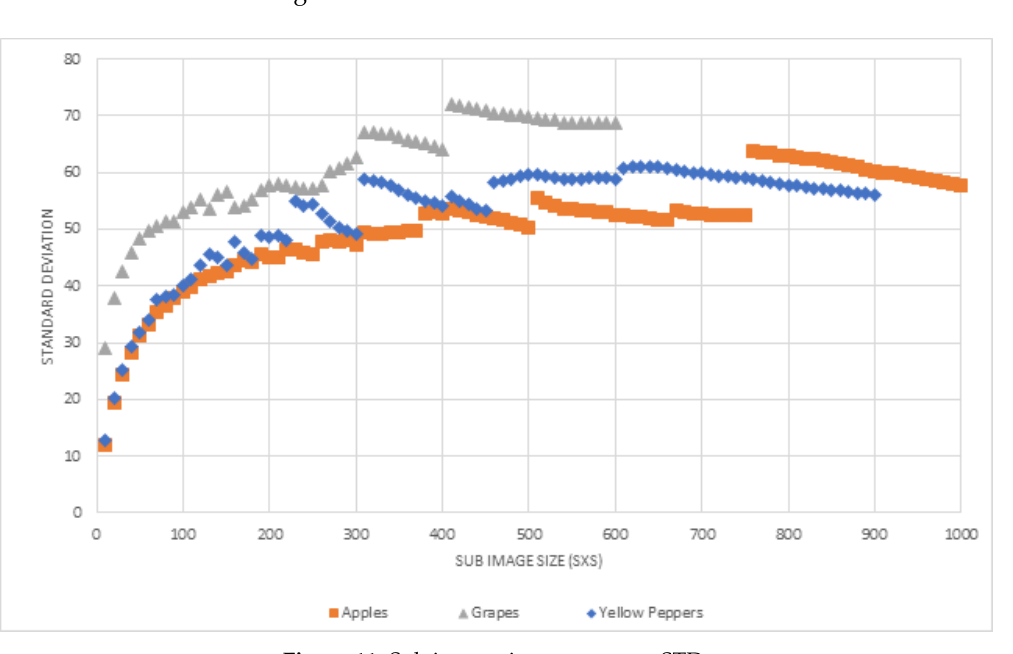
Figure 11. Sub image size vs. average